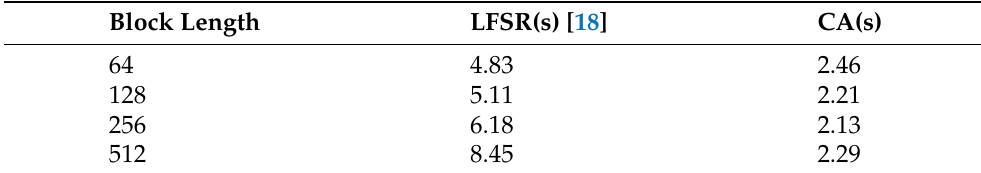
Table 4. Influence of block length on algorithm running